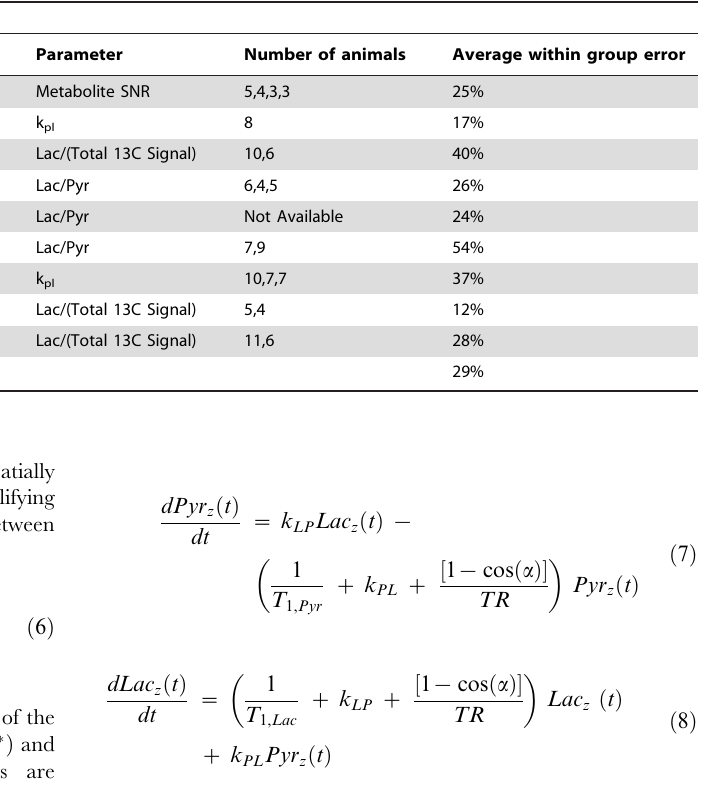
Table 2. Survey of HP parameter variation in recent animal studies.